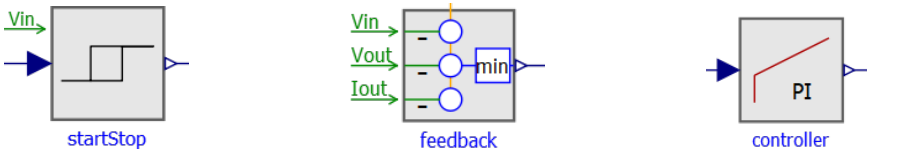
Figure 6. Icons of the components in the control path: start-stop mechanism( left ), determination of feedback error ( middle ) and the PI controller ( right ).